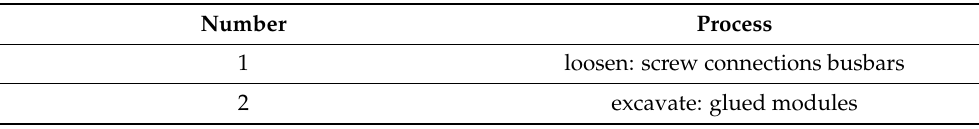
Table A10. Activities of the main processes “classification” and “disassembly”: remove battery modules.